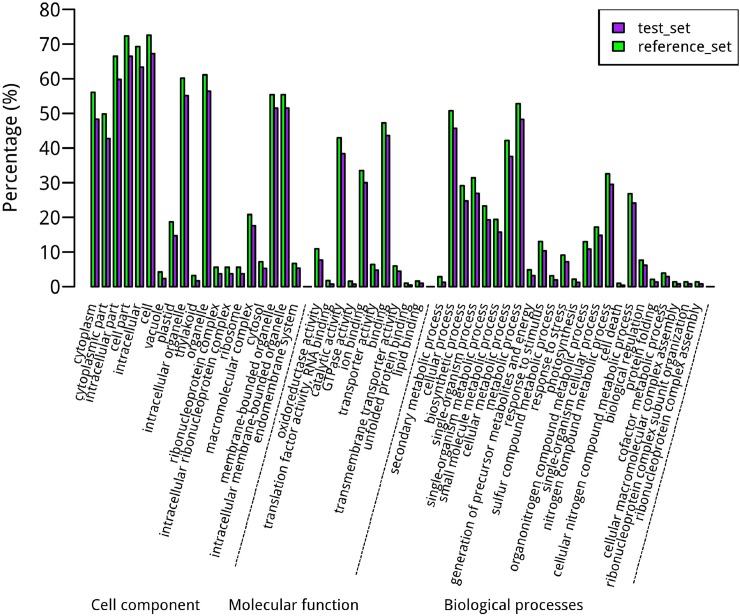
Enrichment analysis for the function of circRNAs as miRNA decoys.The GO terms containing BP (biological processes), MF (molecular functions) and CC (cell components). The GO annotation is presented on the x-axis legend and the percentage of genes on the y-axis legend (Fisher’s test, FDR < 0.05).